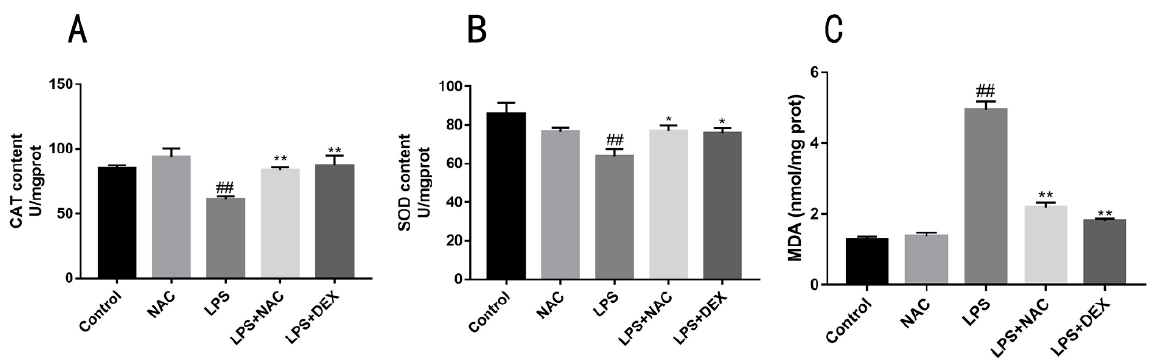
Figure 6. Effects of NAC treatment on LPS ‐ triggered oxidative stress in ALI mice. Effects of NAC on levels of CAT ( A ), SOD ( B ), and MDA ( C ) from lung homogenates are shown. All results are expressed as the means ± SEM ( n = 6 in each group). ## indicates p < 0.01 compared with the control group, and ** indicates p < 0.01, * indicates p < 0.05 compared with the LPS group.